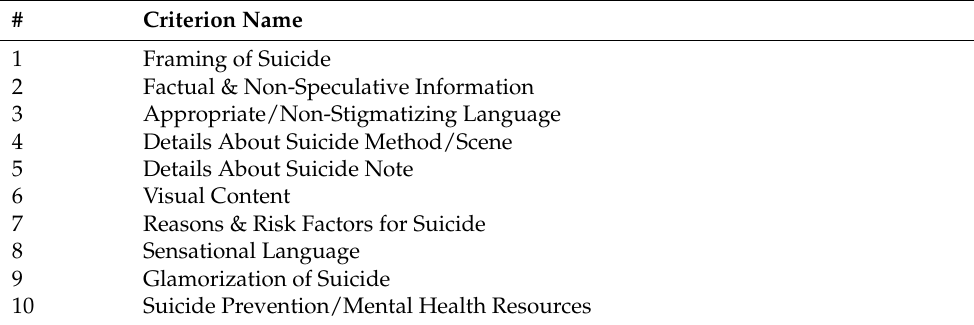
Table 1. Overview of TEMPOS